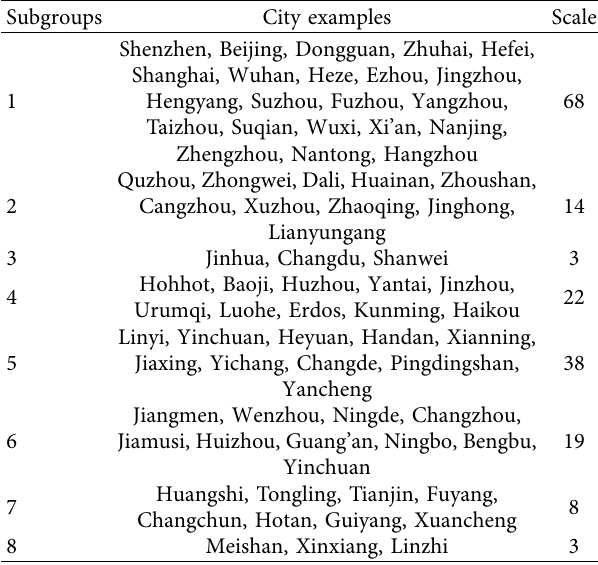
Table 4: Analysis results of cohesive subgroups. Subgroups